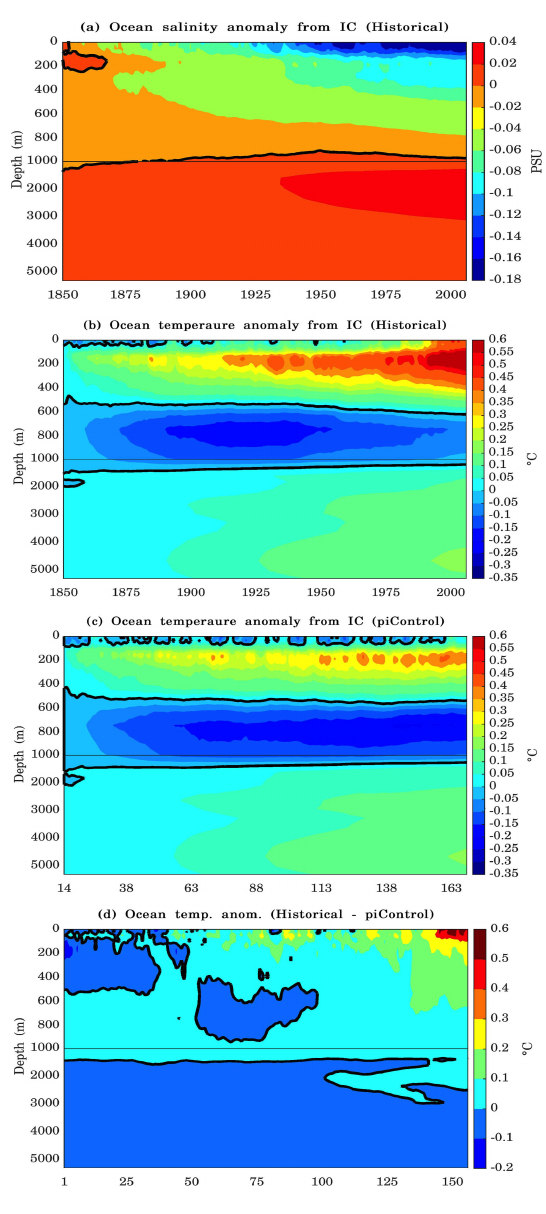
Figure 13. Depth–time Hovmöller diagrams of the global average ocean (a) salinity and (b) temperature anomalies from the respective initial conditions (IC). Here, the initial conditions were taken from the first year for (a, b) historical simulation and from the 14th year for the (c) piControl simulation. The map shown in (d) presents the difference between the temperature anomalies of the historical sim- ulation relative to the piControl. The diagrams are based on annual average time series simulated by the historical simulation over the period 1850–2005 (156 years) and by the piControl simulation over the period 14–169 years (156 years). The thick black line represents the zero contours. Note that the vertical scales are different above and below